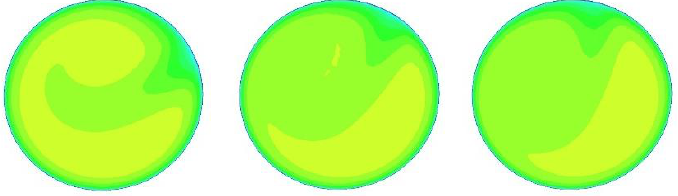
Figure 5. Velocity cloud diagrams at 2, 4, and 6 m/s at x = 50 cm (from left to right).